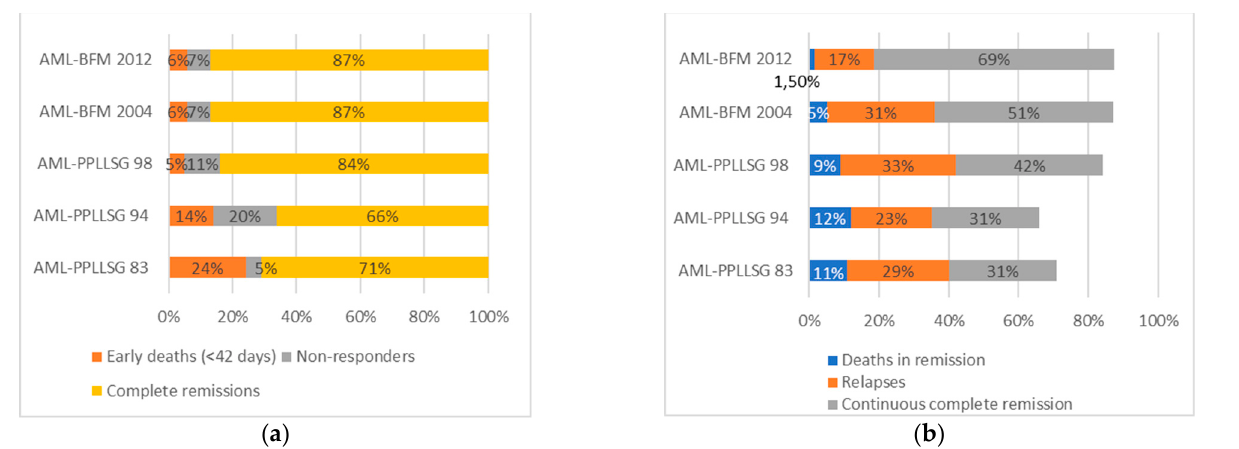
Figure 2. Treatment results. ( a ) Percentages of early deaths, non-responders, achieved complete morphological remissions in the five consecutive periods. ( b ) Percentages of deaths in remission, relapses, and patients in continuous complete morphological remission in the five consecutive periods. Table 6. Treatment results in the five consecutive periods.